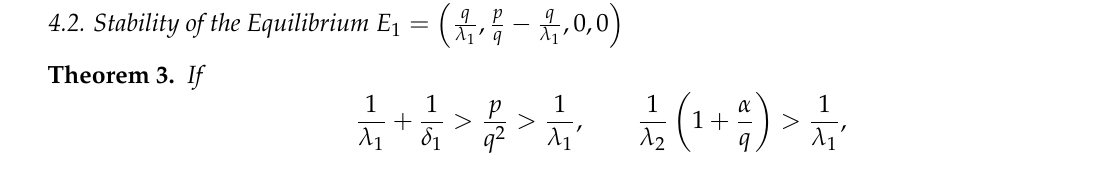
, S ∗ , R ∗ ) = ( 1.1429,0,0,0 ) . 2 1 (cid:16) q − q , p , 0, 0 q λ 1 λ 1